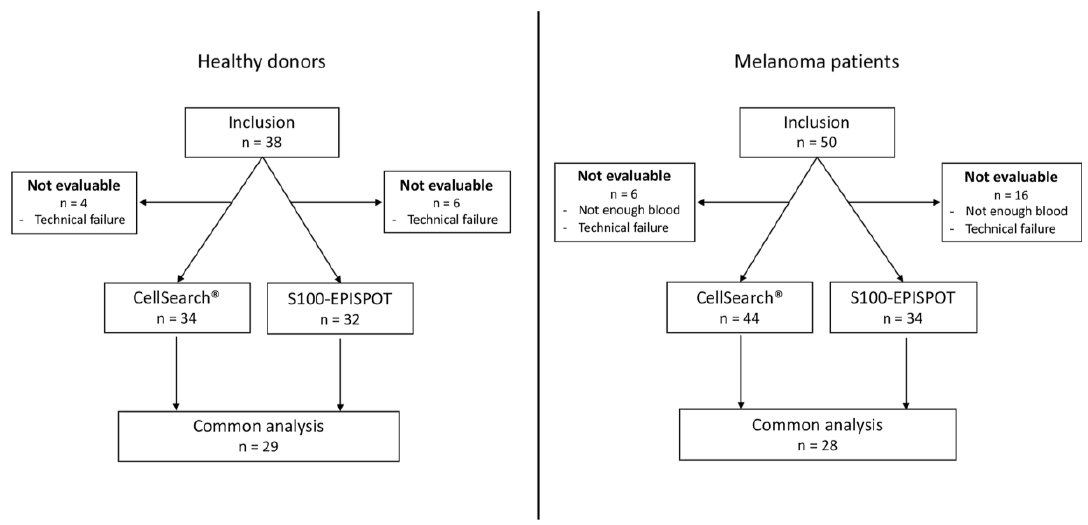
Figure 3. Study flowchart showing the number of included ( a ) healthy donors and ( b ) patients and the number of patients and healthy donors who underwent circulating melanoma cell (CMC) analysis using the S100- EPISPOT assay and CellSearch ® system. Table 1. ( a ) Specificity of the S100-EPISPOT and CellSearch CMC assays in healthy donors using two different CMC cut-offs. ( b ) Sensitivity and specificity of the two assays with the cut-off ≥2 CMCs (healthy donors: n = 28; patients with metastatic melanoma: n = 29).